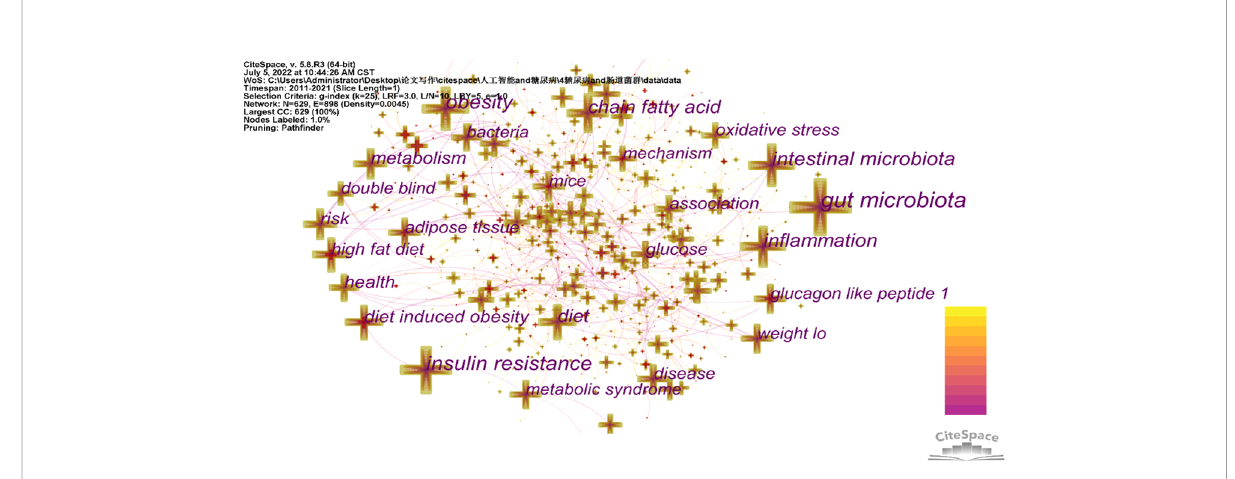
FIGURE 5 Visualization of keyword